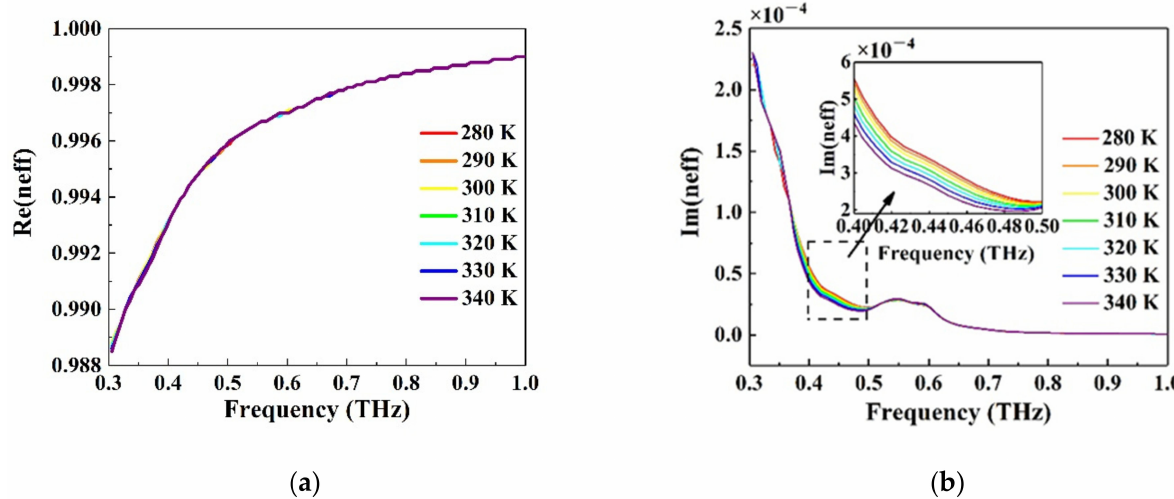
Figure 5. ( a ) Real part and ( b ) imaginary part of the effective refractive index (RI) with water at different temperatures. The inset: detailed information of ( b ) ranging from 0.4 THz to 0.5